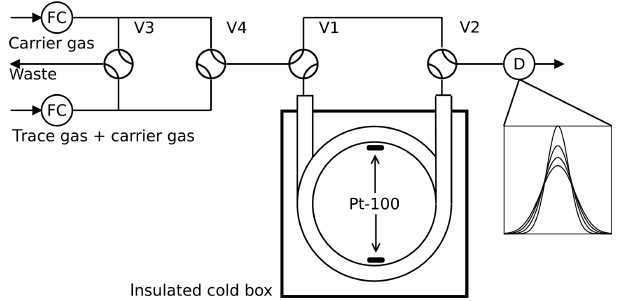
Figure 1. Arrested flow method: a pulse of trace gas is introduced into the column by simultaneously switching valves V3 and V4 for a short time. After the peak has reached the middle of the column, the carrier gas is bypassed by switching V1 and V2 for arrest times t a between 0 and 200s. After each arrest time t a the corresponding peak shape is recorded by the detector D. The gas flow is controlled by flow controller